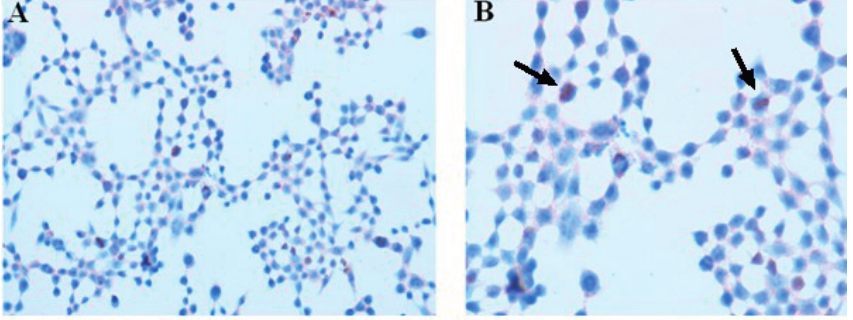
Figure 5. Apoptosis detection assay in the SW620 human colon adenocarcinoma cell line by means of immunocytochemistry. ( A ) Cells were exposed to 3 mM 5-ALA and additionally treated with light (4.5 J/cm 2 ); ( B ) peroxidase in situ TUNEL